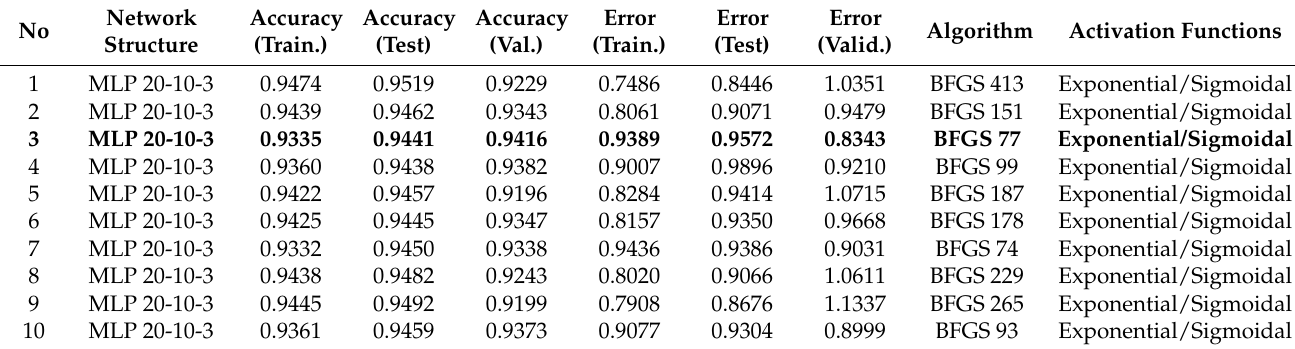
Table 8. List of the artificial neural network with 11 input